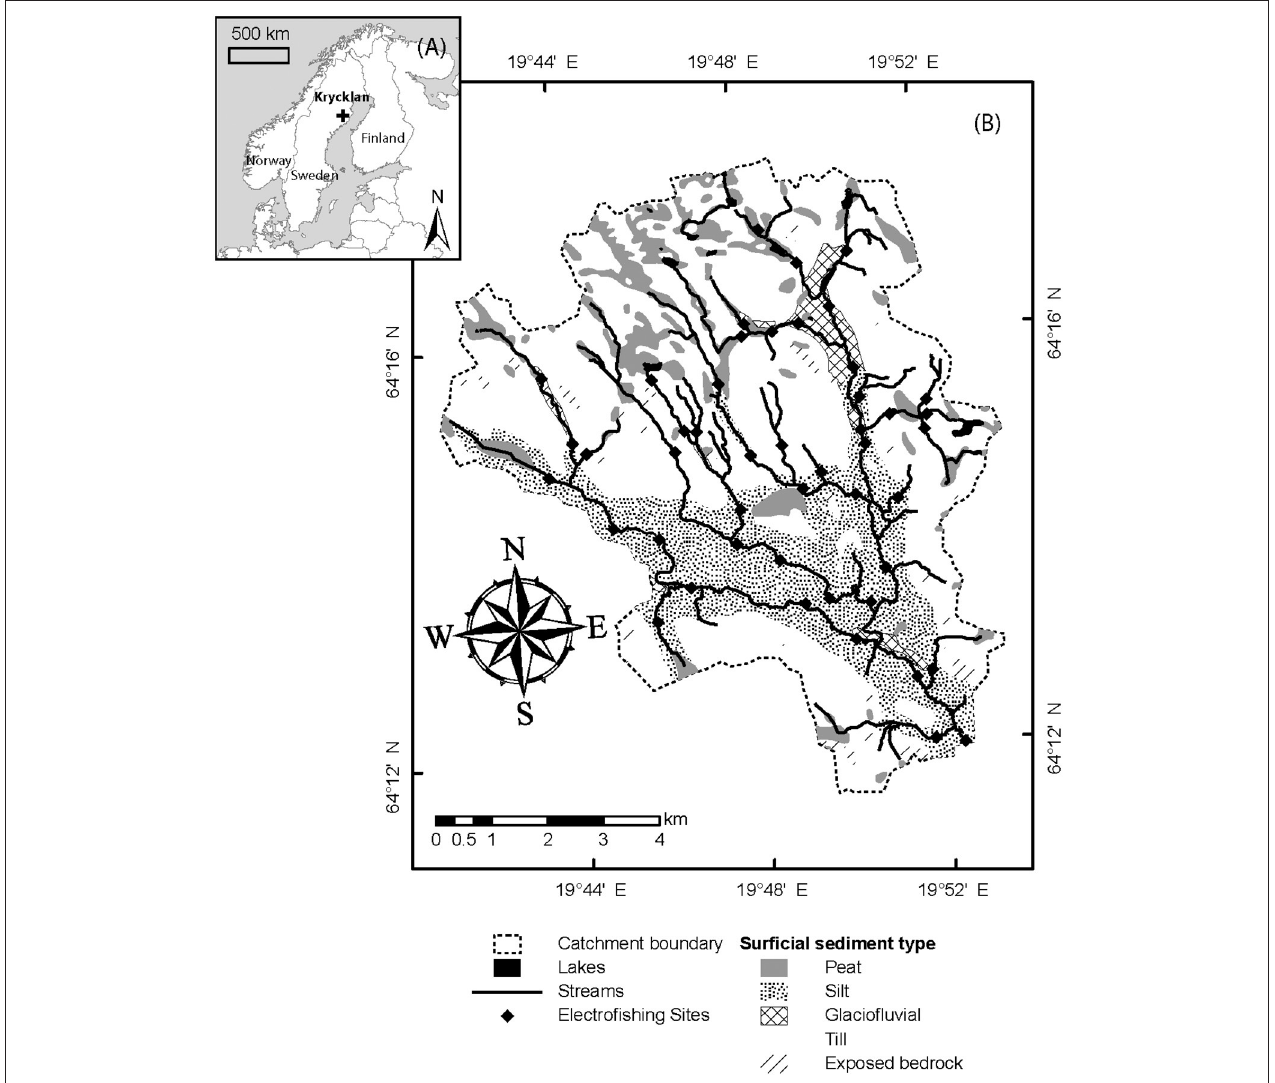
FIGURE 1 | Maps of (A) location within Sweden and (B) Krycklan catchment with surficial sediment coverage and electrofishing sites ( N = 47) marked. Sediment types are described in more detail in the text. Chemistry sampling site locations during spring flood and winter baseflow were similar to those shown here, but with some sites up to a few 100m from the respective fish sampling